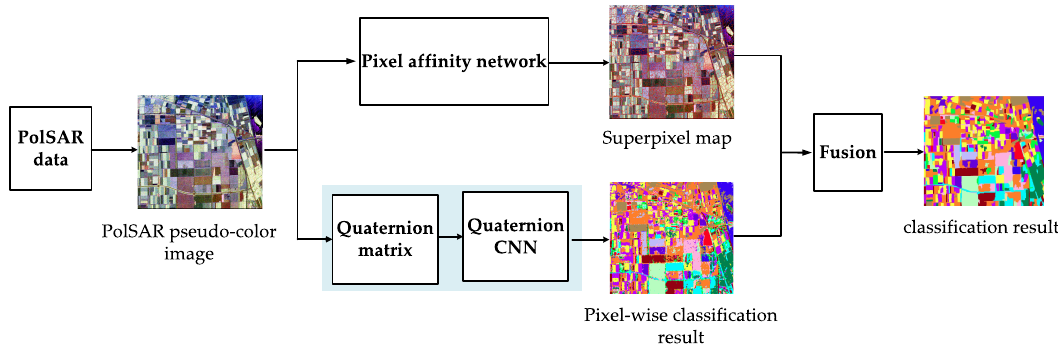
Figure 1. The pipline of the proposed approach. The idea of nearest neighbor (NN) is used to fuse the superpixel map and pixel-wise classification result, which will be described in Section 2.3.2 in